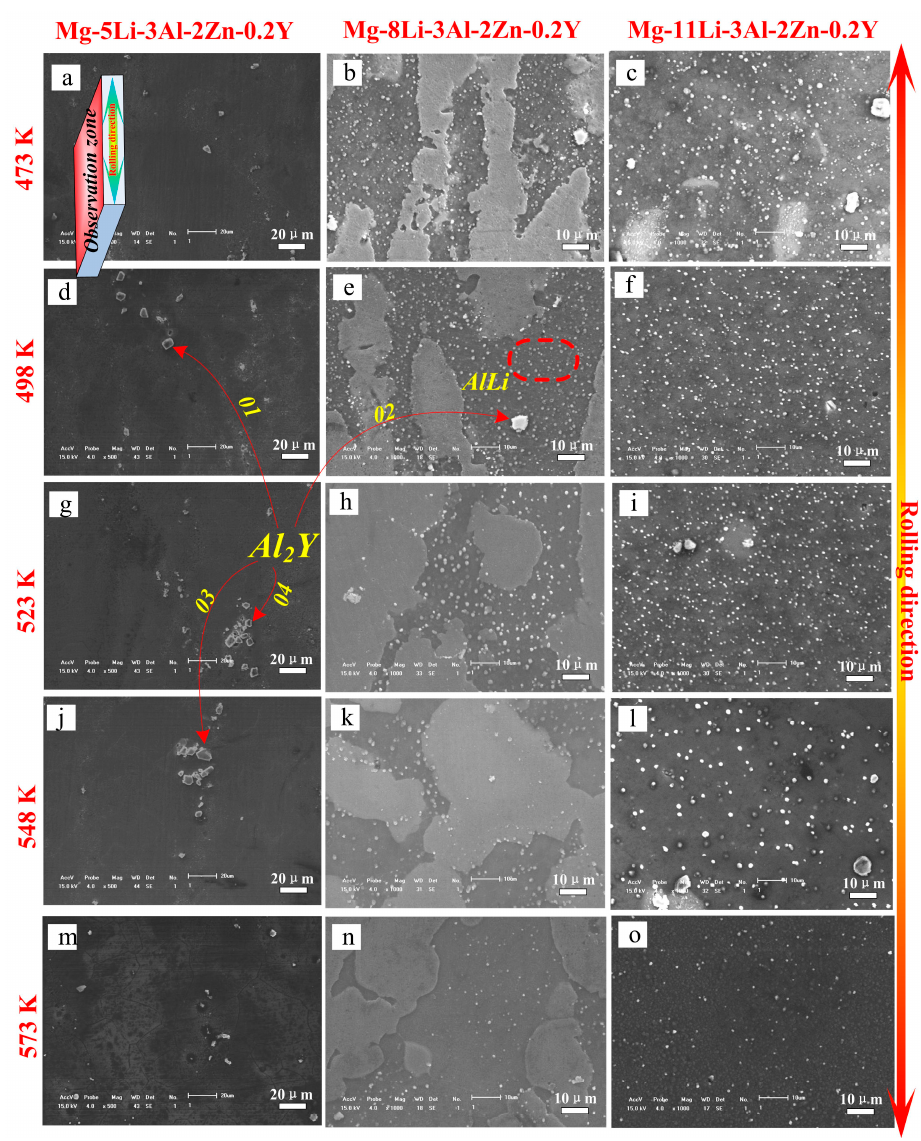
Figure 7. SEM images of the as-rolled alloys annealed at different temperatures for 24 h.